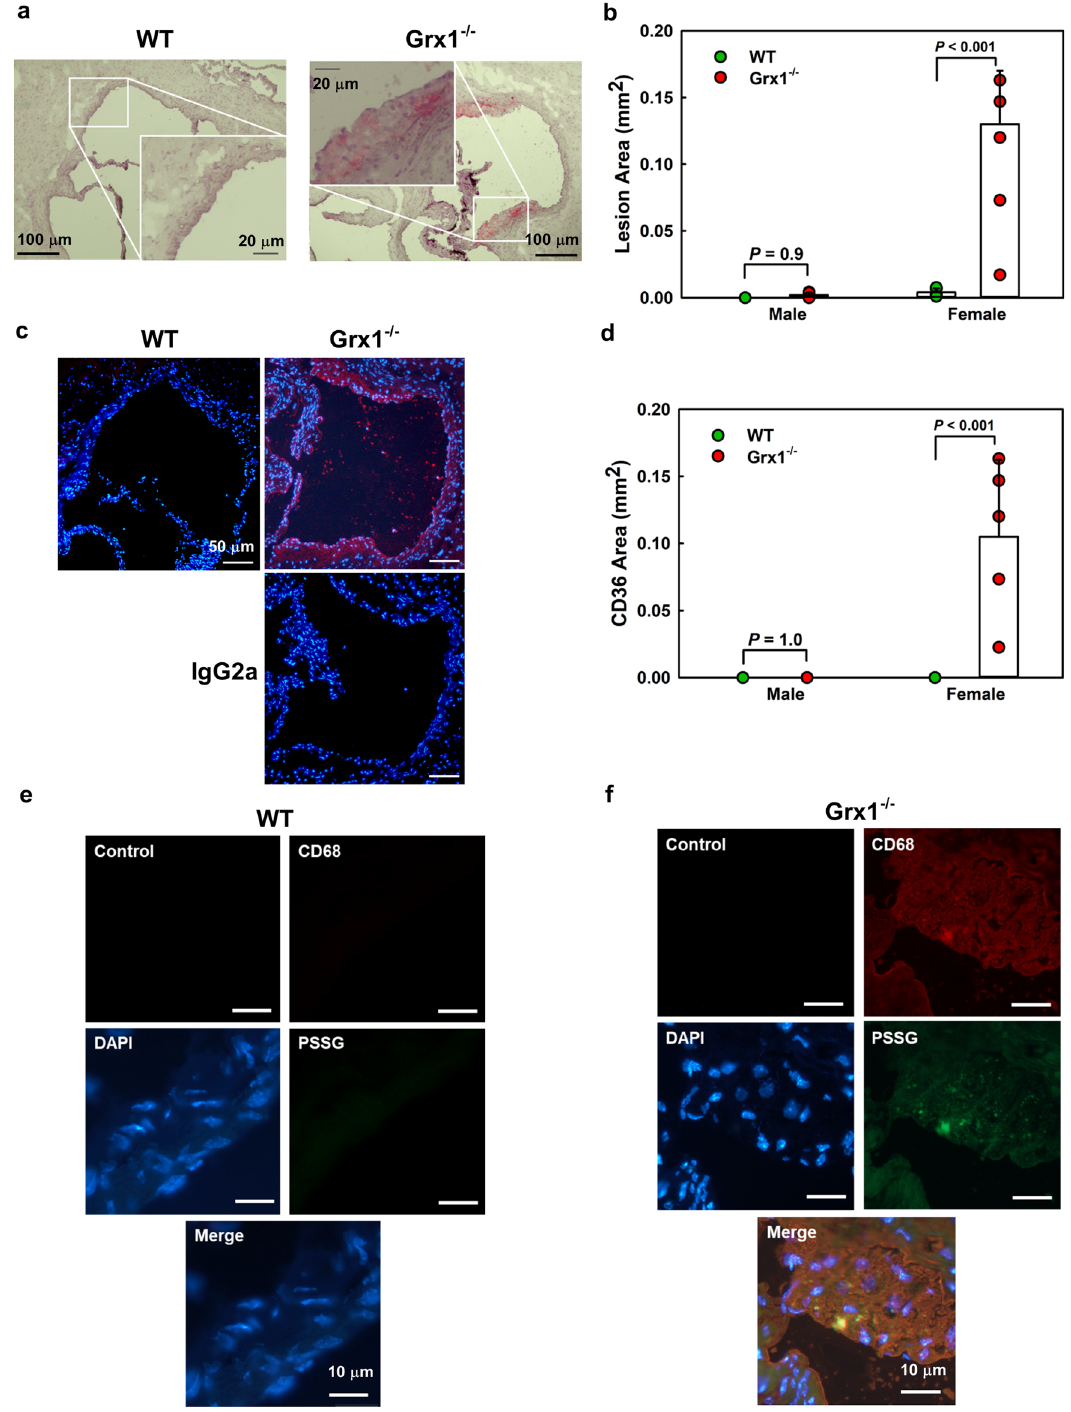
effects of Grx1 de fi ciency in aged female mice is not clear, but reprogramming of the proteome in response to peroxynitrite- mediated protein S -glutathionylation is a likely mechanism 28,29